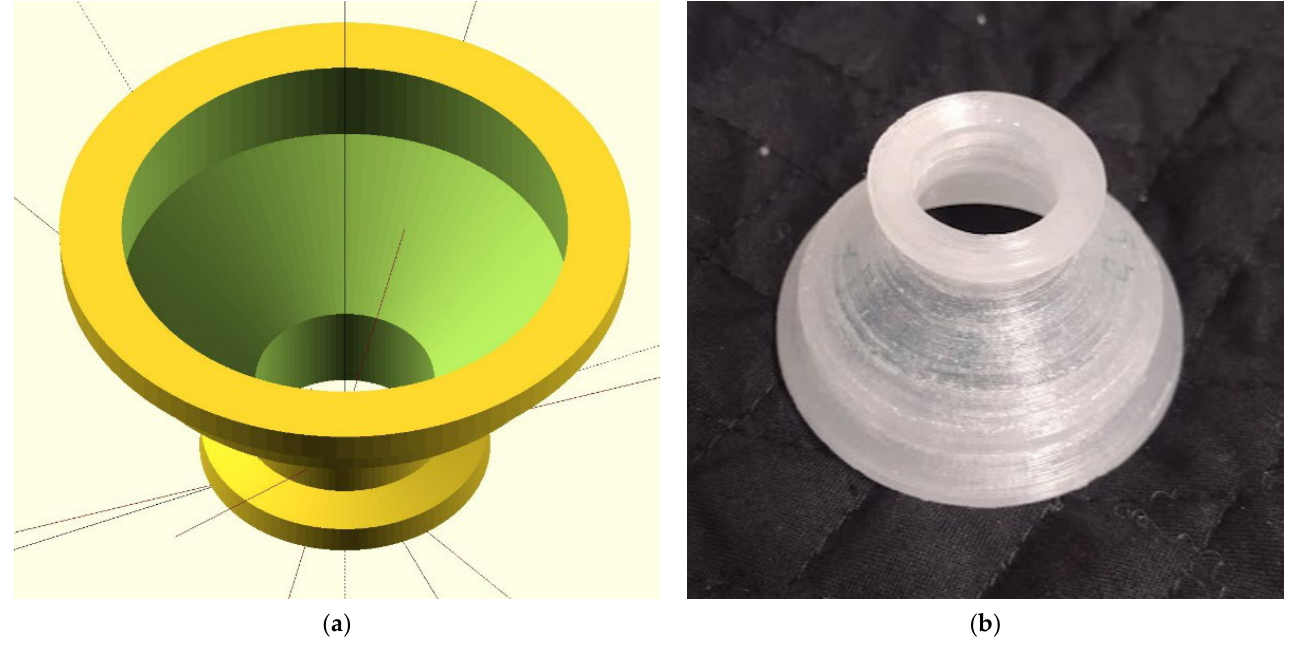
Figure 1. ( a ) OpenSCAD rendering and ( b ) photograph of parts designed for sealing tests.